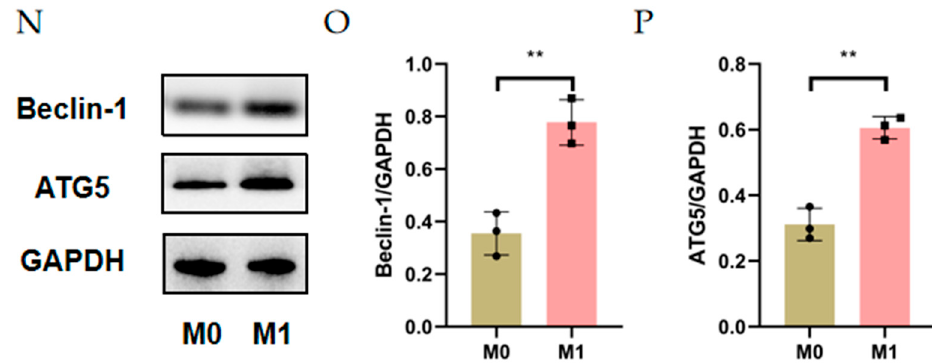
Figure 2. Autophagy level in alkali burn mouse models and macrophage inflammation models. ( A – C ) The mRNA expression of autophagy-related genes (ATG7, Beclin-1, ATG5) in the corneal epithelium analyzed by RT-qPCR. n = 3:3. ( D ) The changes in autophagy-related protein (Beclin-1 and ATG5) expression in the corneal epithelium after alkali burn treatment analyzed by Western blot. n = 3:3. ( E , F ) Quantification of the Western blot result for Beclin1 and ATG5 in ( D ). ( G , H ) The mRNA expressions of CD11b and CD68 were analyzed by RT-qPCR in THP-1 cell line and M0 macrophages. ( I , J ) The mRNA expressions of CD86 and INOS were analyzed by qRT-qPCR in M0 macrophages and M1 macrophages. n = 3:3. ( K – M ) The mRNA expression of autophagy-related genes (ATG5, ATG7, Beclin-1) in M0 macrophages and M1 macrophages analyzed by RT-qPCR. ( N ) The changes in Beclin1 and ATG5 protein expression in M0 macrophages and M1 macrophages analyzed by Western blot. ( O , P ) Quantification of the Western blot result for Beclin1 and ATG5 in ( N ). Unpaired t -tests were used for statistical analyses. ns means no significant difference, * p < 0.05, ** p < 0.01, *** p < 0.001.